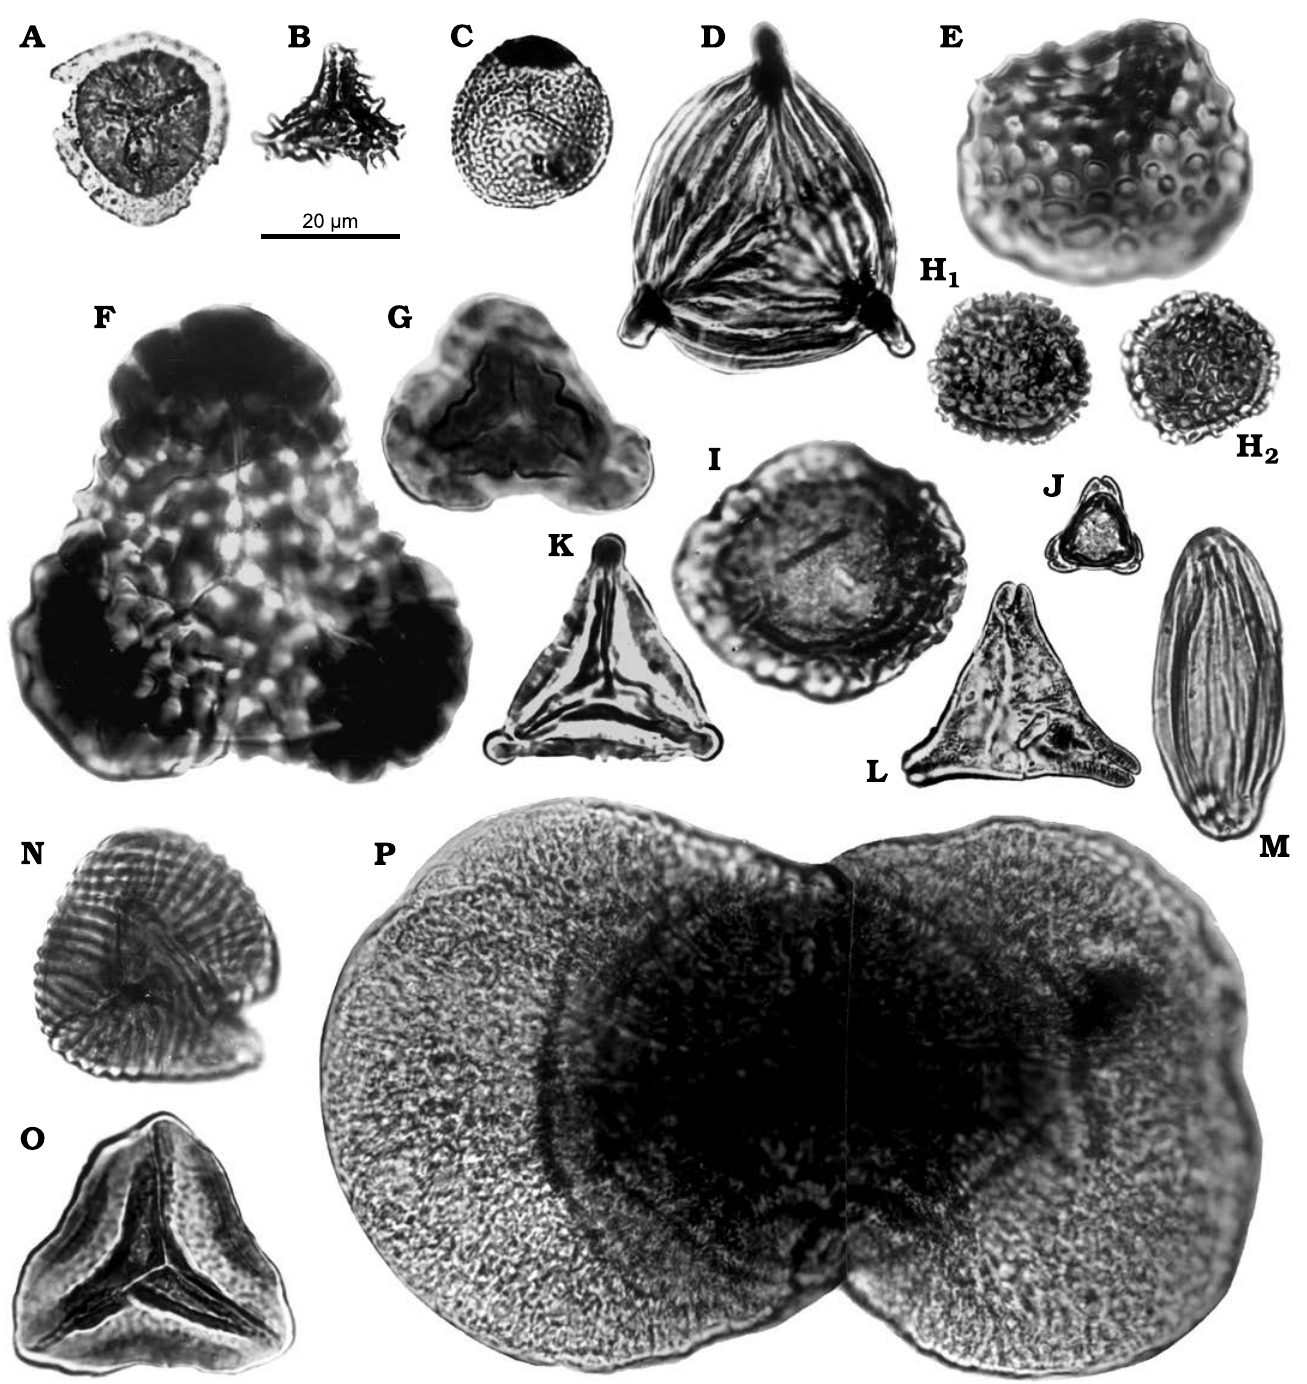
Fig. 19. Spores (A–G, K, N–O) and pollen (H–J, L–M, P) from the North Sudetic Basin, Lower Silesia, Poland, Palynoassemblage B (lower–mid - dle Santonian). A . Cingutriletes clavus Dettmann, 1963, borehole KB18, depth 42.3 m. B . Echinatisporis sp., borehole KB18, depth 42.3 m. C . Baculatisporites parvopunctatus Weyland and Greifeld, 1953, borehole KB18, depth 29.8 m. D . Cicatricosisporites potomacensis Brenner, 1963, borehole KB13, depth 88.6 m. E . Klukisporites pseudoreticulatus Couper, 1958, borehole KB13, depth 94.5 m. F . Trilobosporites sp., borehole KB18, depth 38.3 m. G . Distaltriangulispor ites perplexus (Singh, 1964) Singh, 1971, borehole KB13, depth 94.5 m. H . Catinipollis lwowekensis Raniecka- Bobrowska, 1984, holotype (slide 13/11, 48.5/110.2; repository unknown), borehole KB18, depth 35.0 m; equatorial focal plane (H 1 ), focal plane on the surface (H 2 ). I . Cerebropollenites mesozoicus (Couper, 1958) Nilsson, 1958, borehole KB17, depth 47.5 m. J . aff. Pecakipollis sp., borehole KB8, depth 77.5 mm. K . Clavifera cf. triplex (Bolkhovitina, 1953) Bolkhovitina, 1966, borehole KB13, depth 28.6 m. L . Piolencipollis sp., borehole KB16, depth 99 m; specimen illustrated by Raniecka-Bobrowska (1984, 1989: pl. 218: 2). M . Ephedripites virginiaensis Brenner, 1963, borehole KB18, depth 39.3 m. N . Cicatricosisporites dorogensis Potonié and Gelletich, 1933, borehole KB17, depth 38.0 m. O . Foveogleicheniidites sp., borehole KB18, depth 38.3 m. P . Podocarpidites sp., borehole KB8, depth 84.3 m. Photographs from the unpublished report by Raniecka-Bobrowska